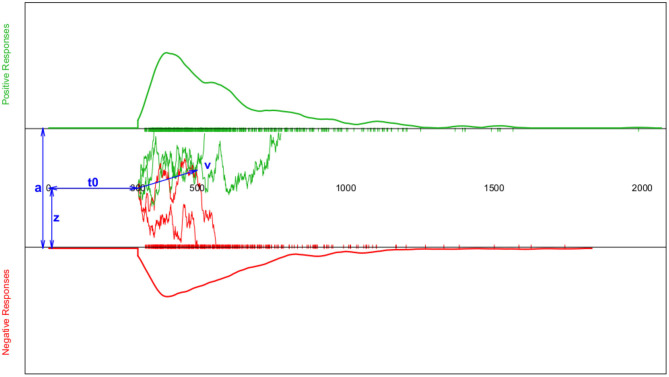
Schematic depiction of the diffusion model and the resulting response time (RT) distributions. The horizontal axis represents the response time. The top section (green curve) shows the RT density estimate for positive responses and the bottom section (red curve) the RT density estimate for negative responses (both accompanied by a rug-plot along the RT-axis); Note that for reaction times shorter than t0, the probability of a response is set to zero. The middle section sketches a few examples of the trajectories representing the information accumulation process assumed to follow a random walk. The blue double-headed arrows indicate the four main model parameters a (boundary separation), z (starting point), t0 (or TER; encoding-and-reaction time; non-decision components), and ν (drift parameter of the random walk).